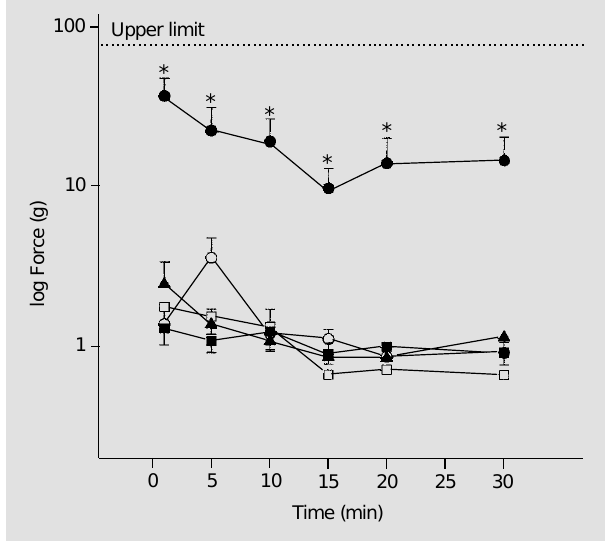
Figure 1 - Time-course of the anti-hyperalgesic effect of electroacupunc- ture in a model of post-incisional pain in rats. The mechanical hyperalge- sia induced by a surgical incision of the plantar surface of the ipsilateral hind paw was evaluated with von Frey filaments. Electroacupuncture was applied over a period of 15 min, beginning 2 h after surgery, and the mechanical threshold then measured within 1 min (time = 0) and re- peated at 5-min intervals for up to 30 min. Control group (N = 10) of non- stimulated rats (open circles); group EA (N = 9) of stimulated rats pretreated with saline (0.1 ml/kg, ip ) 10 min before the stimulation (filled circles); group S (N = 8) of rats stimulated at non-acupoints (open squares); group S-NAL (N = 7) of non-stimulated rats pretreated with naloxone (1 mg/kg, ip ) 10 min before the stimulation (filled squares), and group EA-NAL (N = 7) of stimulated rats pretreated with naloxone (1 mg/ kg, ip ) 10 min before the stimulation (filled triangles). All animals were lightly anesthetized with halothane during the period of effective or sham electroacupuncture. Points are mean ± SEM. *P<0.05 compared to the control group (Mann-Whitney